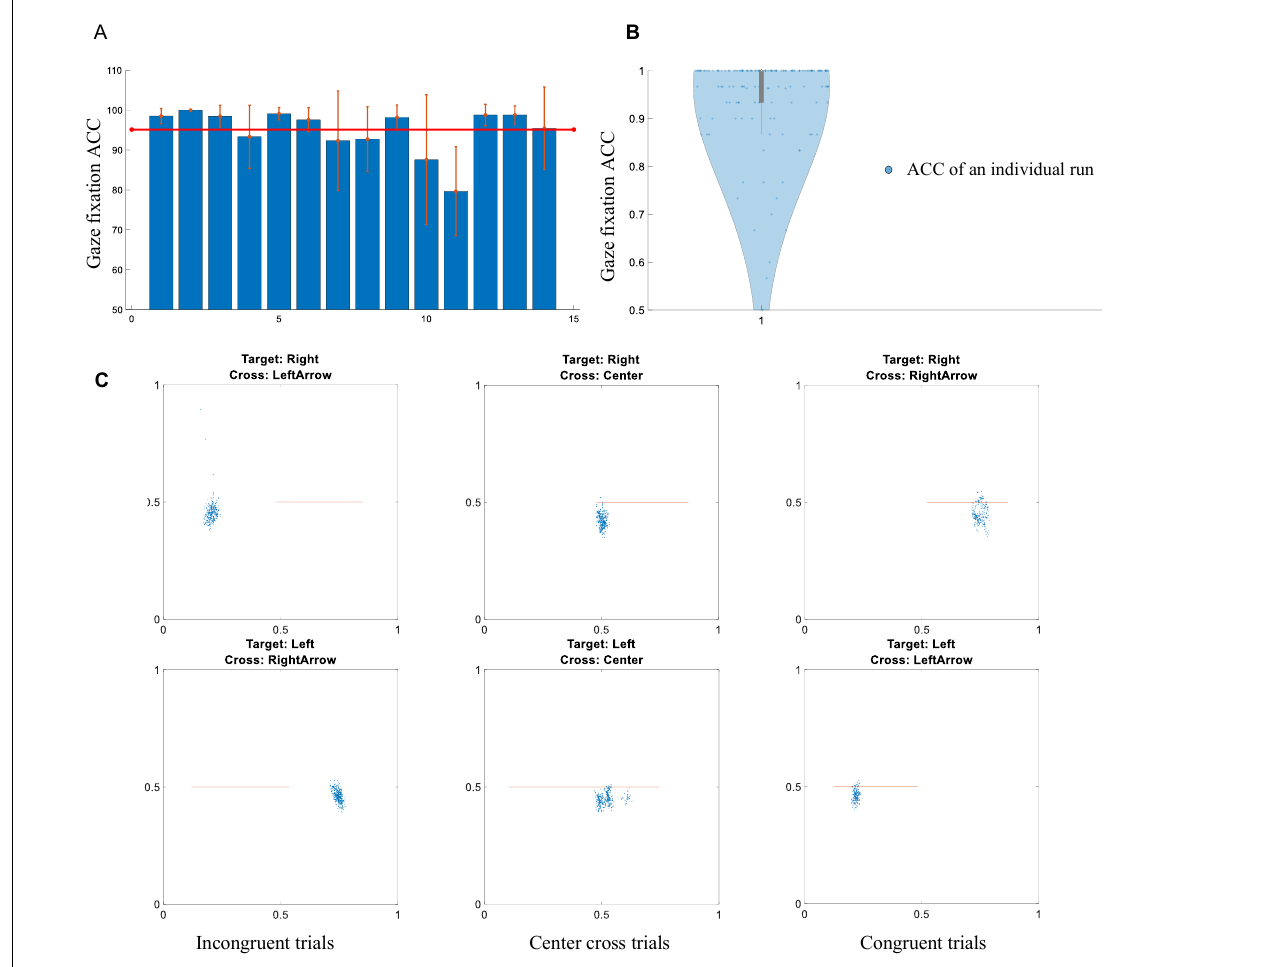
FIGURE 5 | Gaze shift and fixation performance. (A) Individual accuracy ± standard error of gaze shift and fixation. The red line represents a mean value of fourteen subjects. (B) Violin plot of all of subjects’ performance in terms of individual runs. (C) An example of gaze fixation for a particular subject in a randomly selected run. Blue dots represent gaze fixation points, orange lines demonstrate the trajectories of a cursor’s movement. Left column: incongruent trials, middle column: center cross trials, right column: congruent